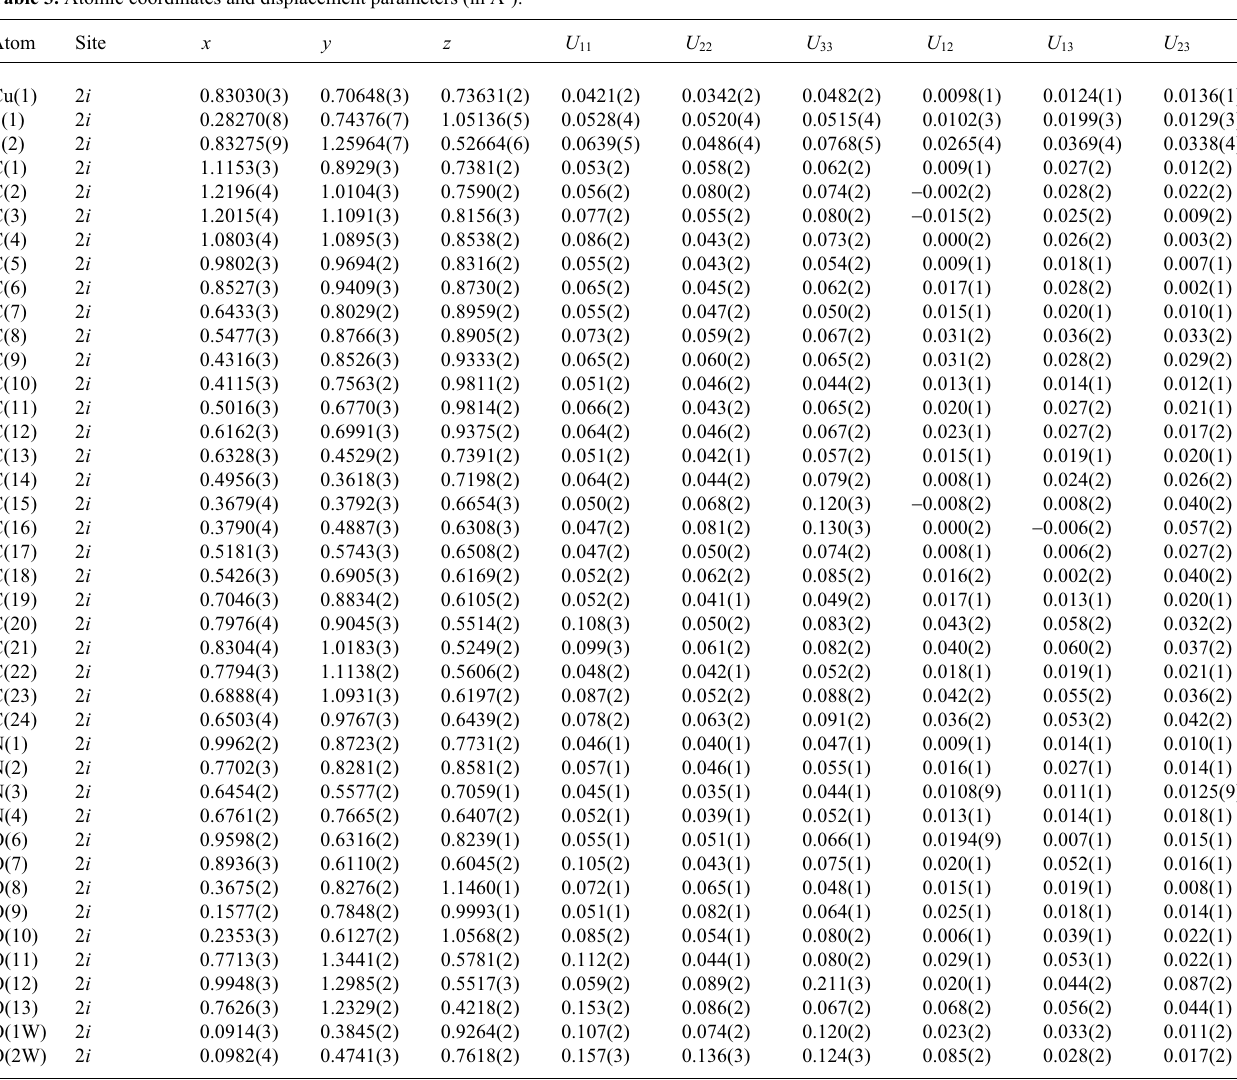
Table 3. Atomic coordinates and displacement parameters (in Å 2 ).